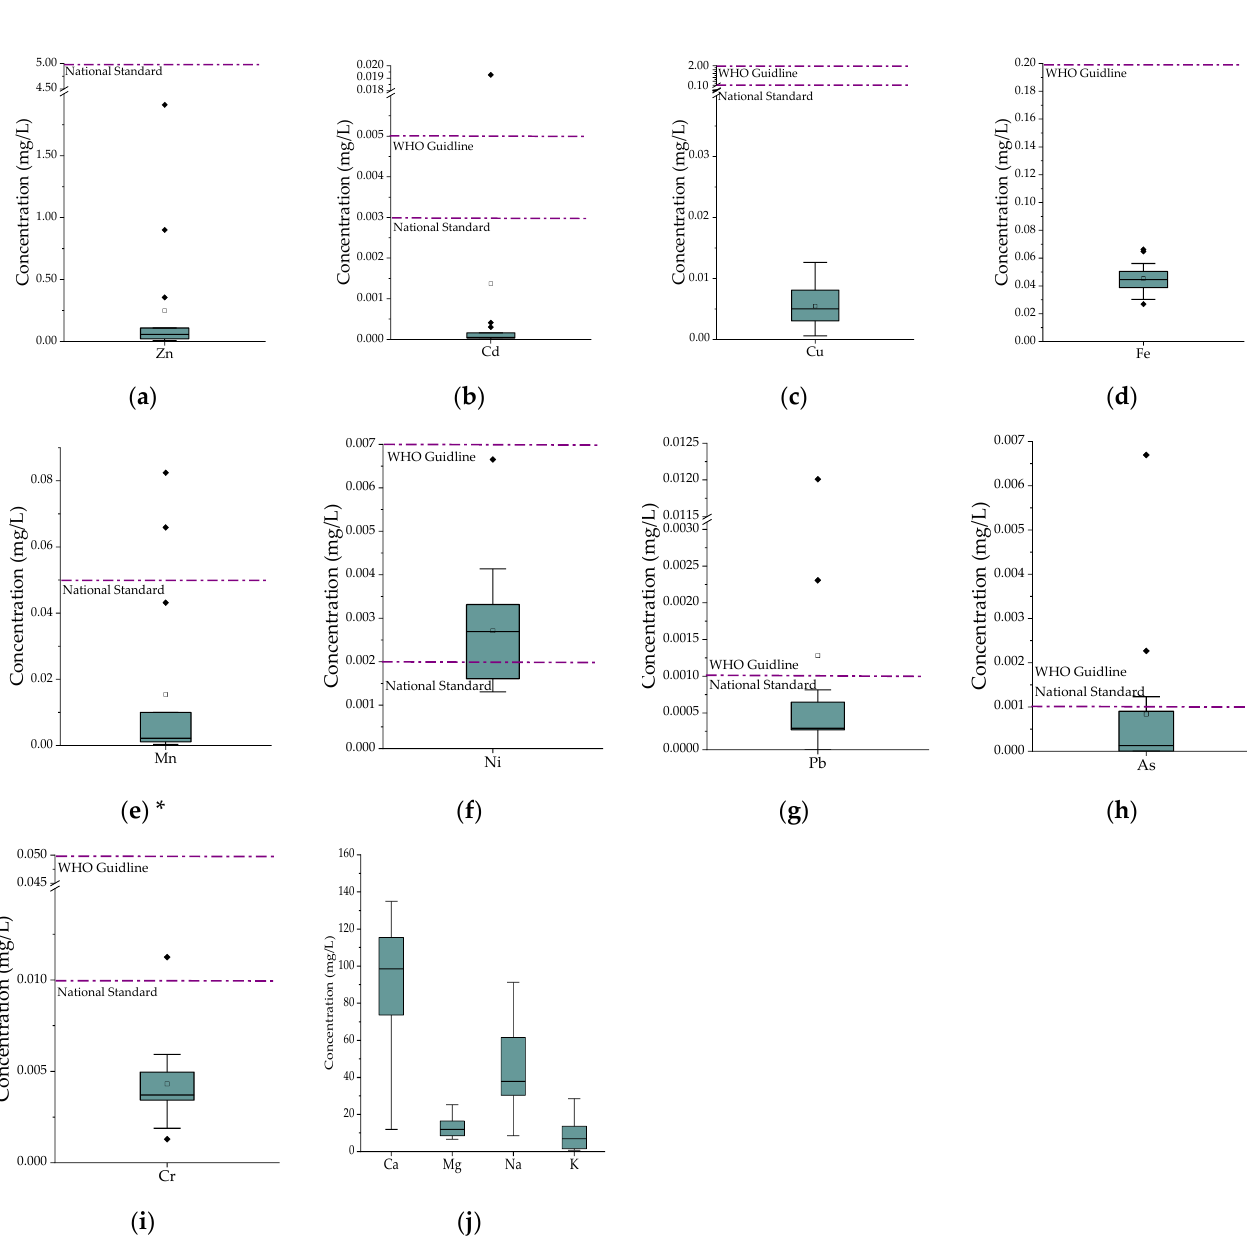
Figure 2. The water samples minor element content (Zn ( a ), Cd ( b ), Cu ( c ), Fe ( d ), Mn ( e ), Ni ( f ), Pb ( g ), As ( h ) and Cr ( i )), in comparison with the WHO guidelines and Romanian national standard values (* guideline values according to Law 458 (2002) and WHO (2011), on drinking water quality) and major element content (Ca, Mg, Na, and K) ( j